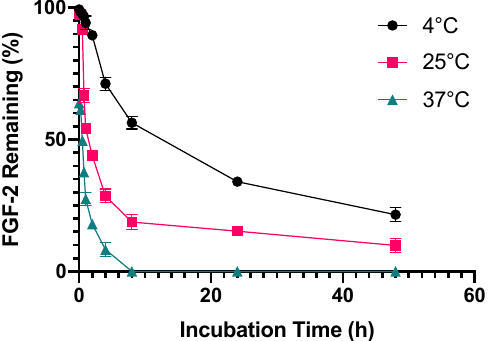
Figure 2. Stability of aqueous FGF-2 solution to different temperatures. FGF-2 solutions (315 pg/mL) reconstituted from the commercial lyophilised powder were incubated at 4 °C, 25 °C and 37 °C for up to 48 h. Residual FGF-2 content measured using an ELISA kit is expressed as a percentage of baseline FGF-2 content (mean ± SD, n = 4).